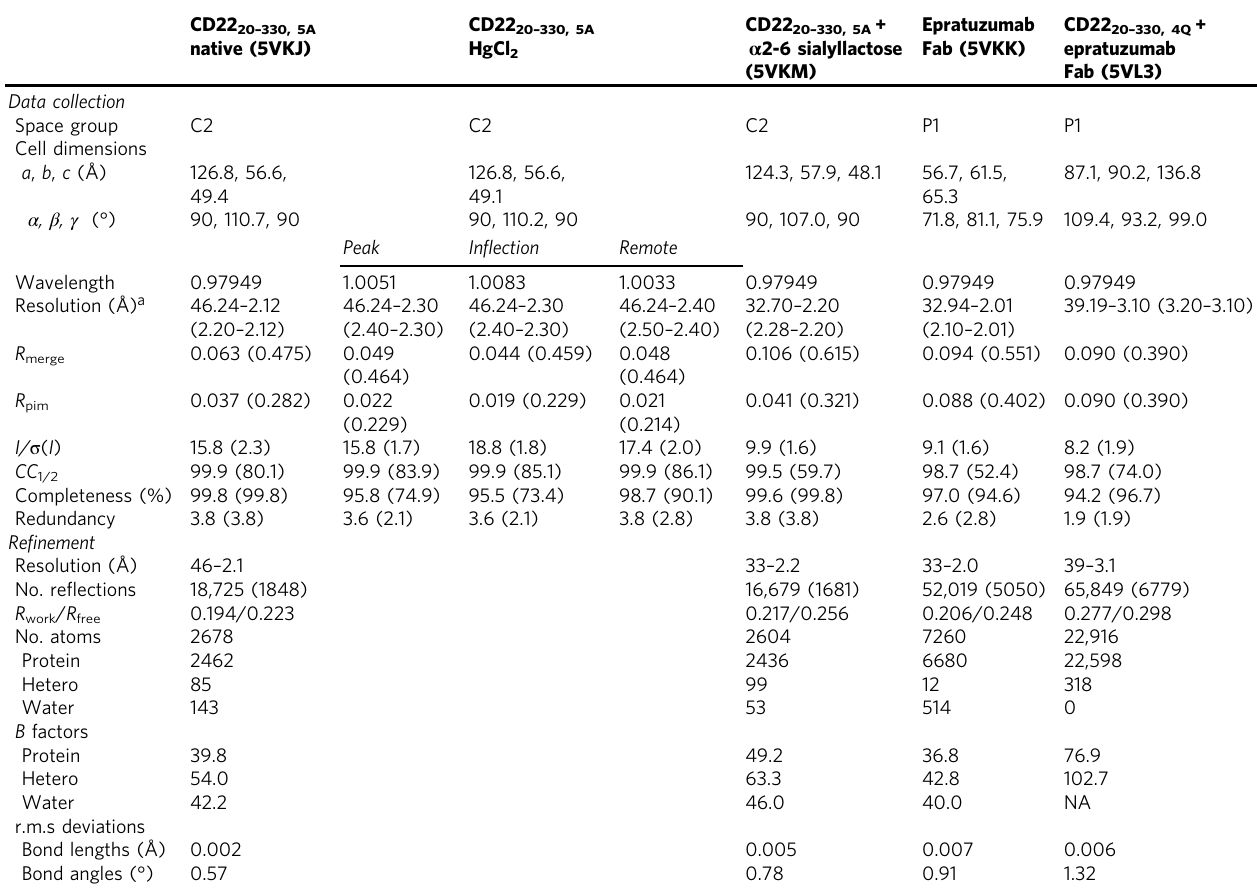
Table 1 Crystallographic data collection and re fi nement